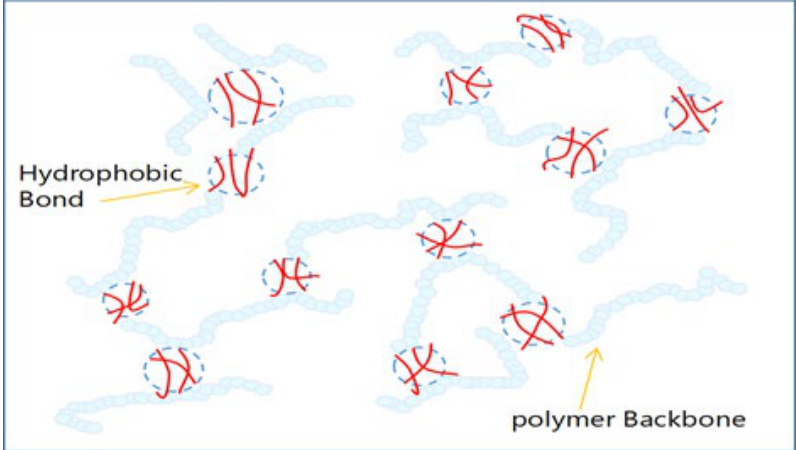
Figure 5. Schematic diagram of interaction between CMC network skeleton and hydrophobic quaternary ammonium chain.